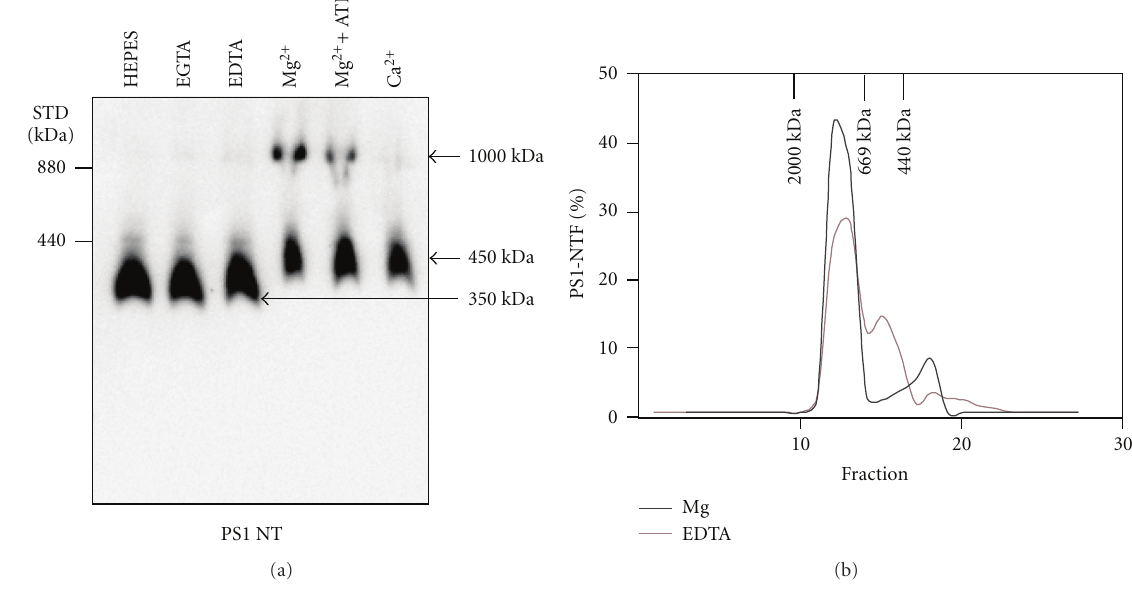
Figure 5: E ff ect of Ca 2+ and Mg 2+ on the size of γ -secretase complexes analyzed by BNPAGE and size-exclusion chromatography. 10 μ g samples of protein extract from SHSY5Y membranes were incubated with HEPES bu ff er, pH 7.3, with or without additives, as indicated. EGTA and EDTA concentrations were 2mM. CaCl 2 and MgCl 2 concentrations were 3mM. (a) The incubations were mixed with BN-PAGE sample bu ff er and electrophoresed on 3–8% Tris-acetate gels. Proteins were transferred to PVDF membrane and the blot probed with anti- PS1 antibody 98/1. (b) SH-SY5Y membranes (200 μ g per experiment) were extracted with 0.5% CHAPSO in bu ff er containing either 2mM EDTA or 3mM MgCl 2 . The samples were chromatographed on superose-6 size-exclusion column and eluted fractions were analysed by western blotting with PS1 N-terminal antibody 98/1. Western blot signals were quantified and plotted against fraction